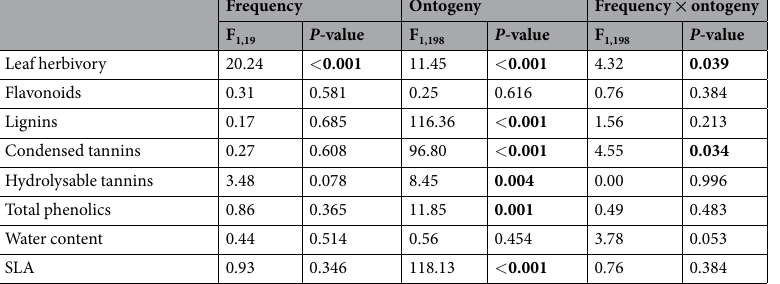
maintained or decrease during the adult stage 19, 20 . In addition to endogenous processes such as allocation con- straints, plant variation in defence investment may also be explained by the risk of being attacked by herbivores. According to classic theory, plants that are easier to find (i.e., more apparent) either because they are larger in size, more abundant, or long-lived should invest more in defences than smaller, less abundant or ephemeral plants (Plant Apparency Theory 21 ). Although studies testing this prediction have mostly focused on inter-specific com- parisons, we could extend this framework to make predictions about intra-specific variation, particularly that occurring over ontogeny. In this case, adult plants, which are visually (due to their larger size) or chemically (due to greater emission of volatiles used as cues by herbivores) more conspicuous than young plants, should be easier to detect by insect herbivores and therefore experience higher herbivory and in turn greater investment in defences. To date, theory on neighbourhood effects and the ontogeny of plant defence have developed independently for the most part, despite there being important insights to be gained from merging the two. The importance of joining these bodies of research resides in that there is a large potential for neighbourhood features and ontoge- netic variation to interactively shape plant defences and herbivory. Neighbourhood effects on herbivory may be contingent on plant ontogeny if young and adult individuals vary in the risk of being detected by herbivores or if neighbourhood effects on plant defences (via plant-plant interactions) vary with plant age (e.g., due to differences in allocation constraints) and this in turn influences damage. Likewise, predictions for ontogenetic differences in herbivory and allocation to defences may vary depending on the neighbourhood context, where for example differences in apparency between adult and young plants of a focal plant species might be weaker in heterospe- cific relative to conspecific neighbourhoods, or similarly, in heterospecific neighbourhoods with a high vs. low frequency of that host plant (i.e., resource concentration effects increasingly overrule ontogenetic differences with decreasing host plant frequency). In the present study, we tested for the independent and interactive effects of plant neighbourhood type (low vs. high frequency of a focal plant species in heterospecific stands) and ontogenetic stage on insect leaf herbivory, and leaf physical traits (water content and specific leaf area), and leaf chemical defences (phenolic compounds) in the English oak, Quercus robur L. (Fagaceae), a long-lived tree common throughout western Europe. To understand the linkage between plant traits and herbivory, we further tested whether and which plant traits were associated (and potentially mediated) neighbourhood and ontogenetic effects on Q. robur leaf herbivory. To this end, we surveyed saplings and adult trees of Q. robur found in 20 field sites across north-west Spain. At each site, we selected two adjacent stands similar in size and total plant density: one with a high frequency of Q. robur indi- viduals ( > 85% of the adult individuals were of the focal species) and another with a low frequency of this species ( < 35% of the adult individuals were of the focal species). In both cases, stands were composed of Q. robur plus two other tree species; the identity of these non-focal species was the same in all cases (i.e., tree species composi- tion was held constant across stands). In addressing the above, this study builds towards a better understanding of the combined effects of plant neighbourhood and ontogeny on plant-herbivore interactions and plant traits associated with such effects.